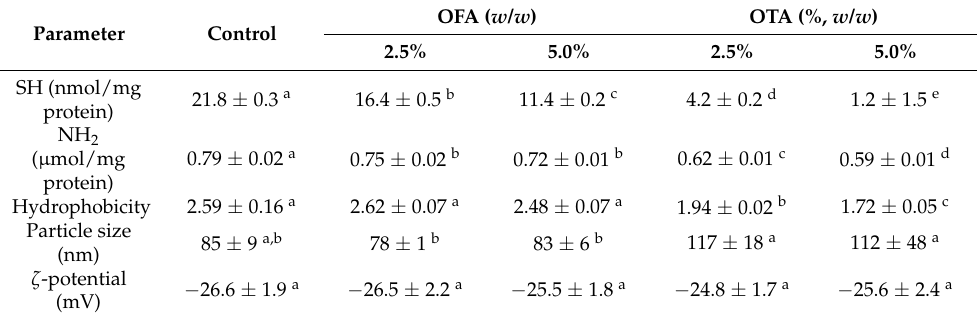
Table 1. Physicochemical changes in oxidized ferulic (OFA) and tannic (OTA) acid-treated WPI.